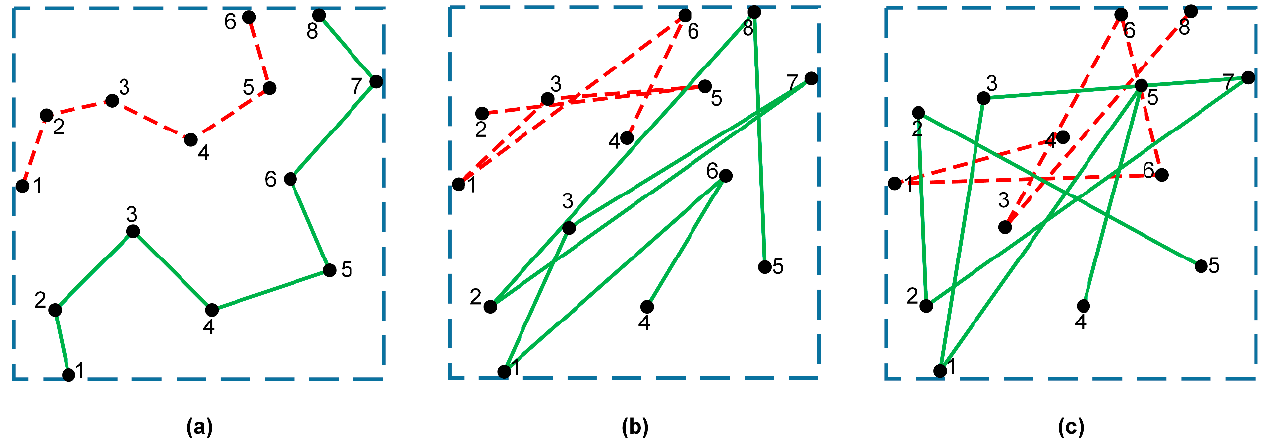
Figure 2. Scrambling of the GIS vector map data. ( a ) Original vector map data, ( b ) scrambling within objects, ( c ) scrambling between objects.